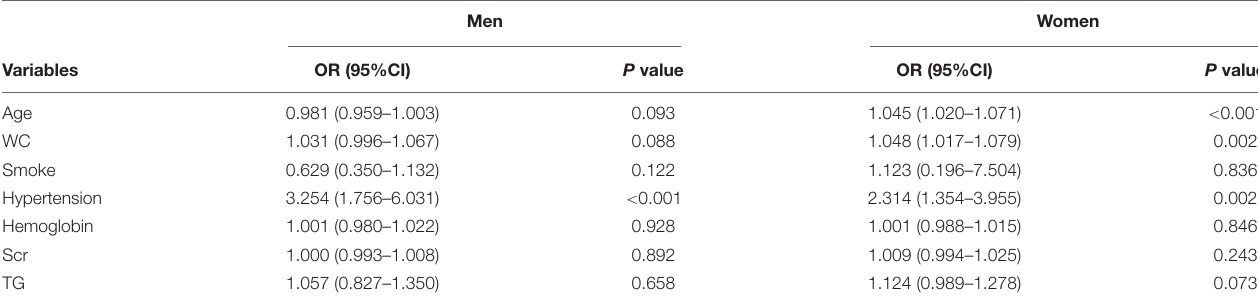
TABLE 3 | Association between serum uric acid and cardiovascular risk factors according to gender